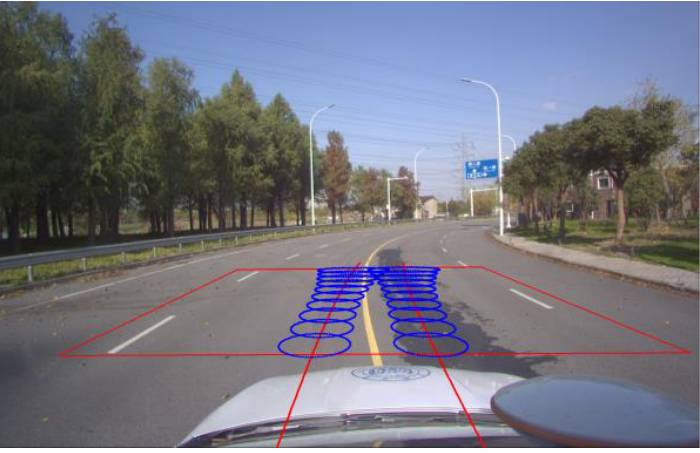
Figure 7. The reckoned trajectory and uncertainty distribution in the image coordinate system.